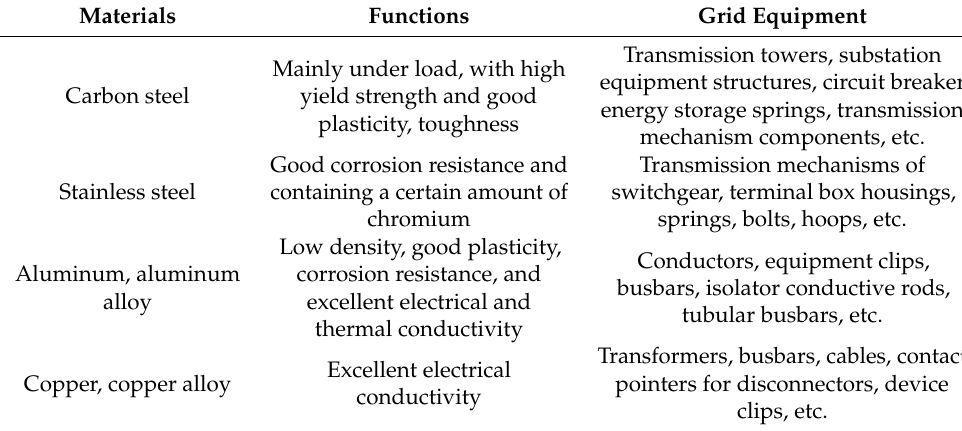
Table 1. Introduction of metal materials commonly used in power